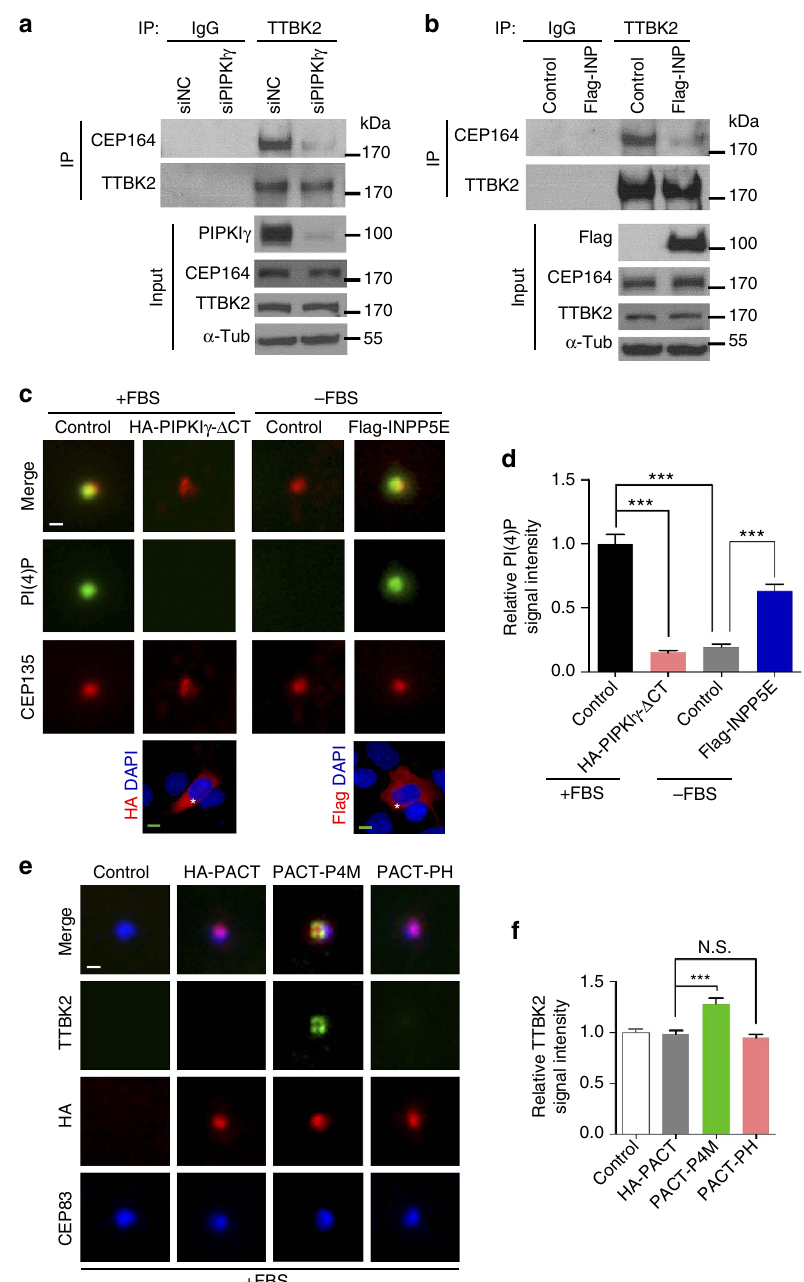
Figure 5 | PIPKI c and INPP5E coordinate the association between TTBK2 and CEP164 by regulating a centrosomal PtdIns(4)P pool. ( a , b ) HEK293T cells transfected with indicated siRNAs ( a ) or plasmids ( b ) were subjected to immunoprecipitation (IP) with anti-TTBK2 antibody or normal rabbit IgG (IgG). Flag-INP, Flag-INPP5E. The resulting precipitates and cell lysates (Input) were immunoblotted with indicated antibodies. a -Tub, a -tubulin. ( c ) IMCD3 cells were transfected with empty vector (Control), HA-PIPKI gD CTor Flag-INPP5E. Without ( þ FBS) or with 6-h serum starvation ( (cid:2) FBS, most cells were not yet ciliated under this condition), each group of cells was subjected to IF microscopy to visualize PtdIns(4)P (PI(4)P, green), CEP135 (red), HA-tag (far-red) and nuclei (blue, DAPI staining). Stars indicate transfected cells. ( d ) In each group in c , the intensity of centrosomal PtdIns(4)P signal in 4 20 cells was quantified and plotted from at least three independent experiments. ( e , f ) RCTE cells stably expressing GFP-TTBK2 were transfected with HA-tagged PACT, PACT-P4M SidM (PACT-P4M) or PACT-PH PLC d (PACT-PH) for 24h. Cells were then processed for IF microscopy with antibodies against TTBK2 (green), HA-tag (red) and CEP83 (far-red, pseudo-colored blue). ( f ) The fluorescence intensity of centrosomal TTBK2 was quantified in 4 20 cells of each group. Results from three independent experiments were plotted. Error bars represent s.e.m. *** P o 0.001. Scale bars, 5 m m (green); Scale bars, 0.5 m m TTBK2. After serum starvation, INPP5E is removed from the basal body through unknown mechanism, which leads to a decrease of local PtdIns(4)P level at the distal end of the basal body. This facilitates the association of TTBK2 with CEP164, and in turn triggers CP110 removal and downstream axoneme elongation.